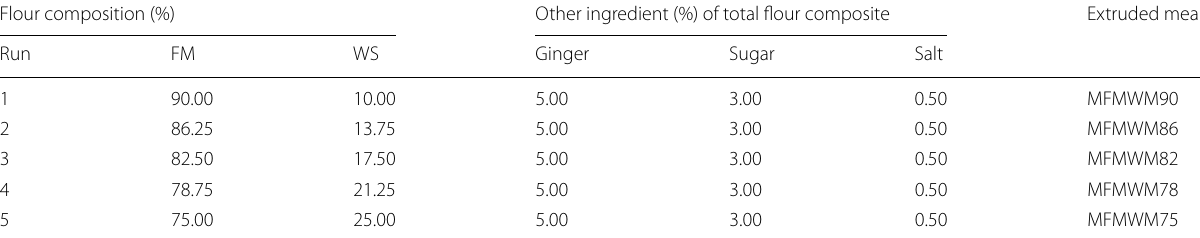
FM finger millet flour, WS watermelon flour